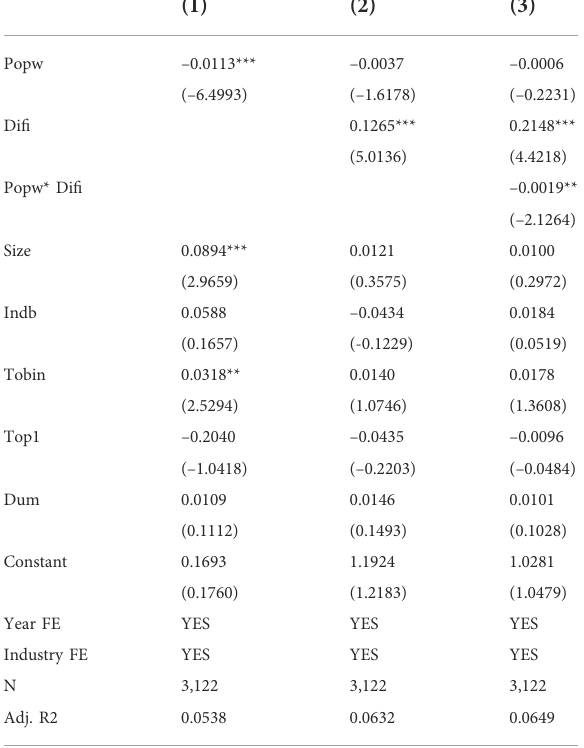
TABLE 8 Re-test based on samples of heavy-polluting